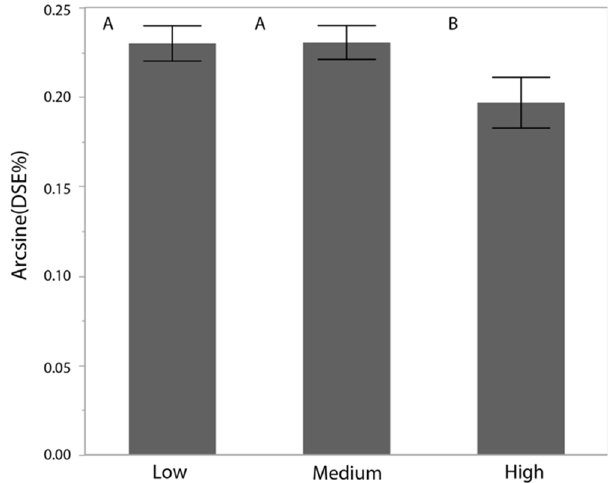
Figure 4. Arcsine-transformed Dark Septate Endophyte Infection-rates by Tolerance Group. Histogram of Arcsine-transformed dark septate fungal endophyte infection-rates between drought tolerance groups (Low, Medium, and High drought tolerance). Infection rates were determined by dividing the number of infected root cells by the total number of cells observed through microscopy. Connecting letters report indicates significance at alpha-level 0.05. Error bars are standard error of the